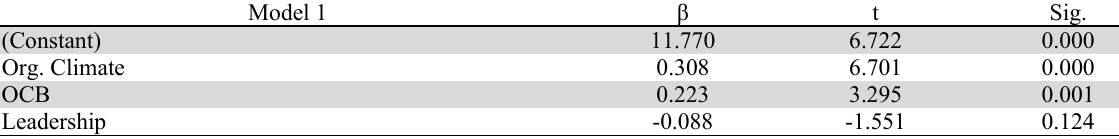
Hypothesis test of independent variables on job